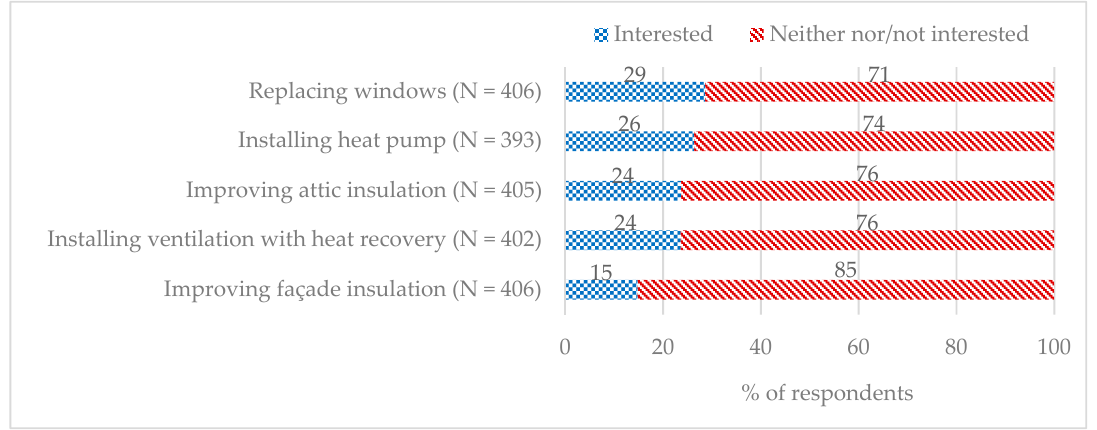
Figure 2. The interest of homeowners in adopting different energy efficiency measures (EEMs).